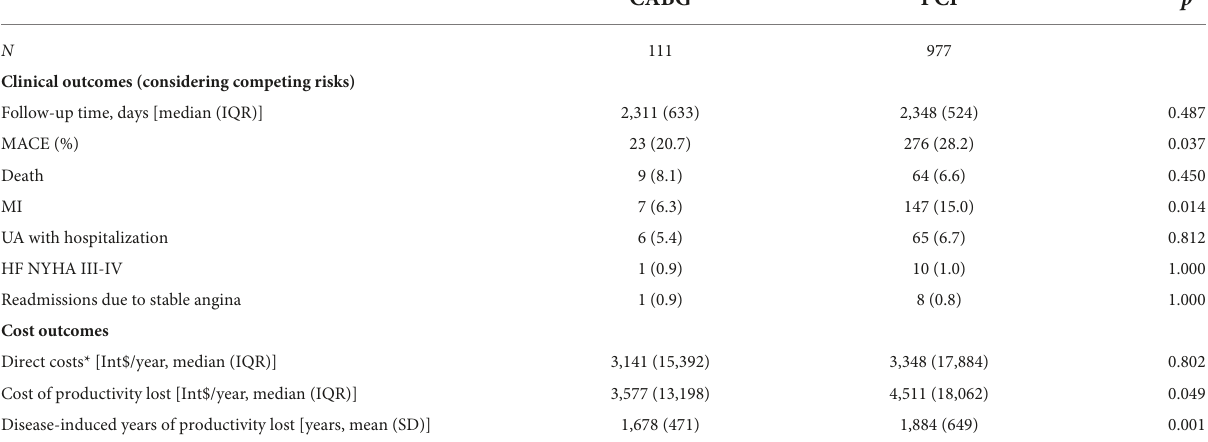
TABLE 1 Clinical and cost